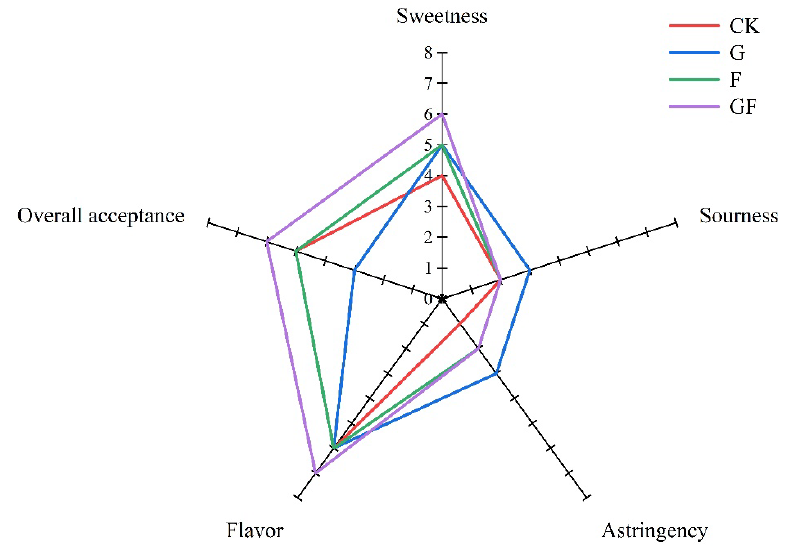
Figure 6. Effects of girdling and foliar fertilization with K on the sensory properties of ‘Hanxiangmi’ table grapes.